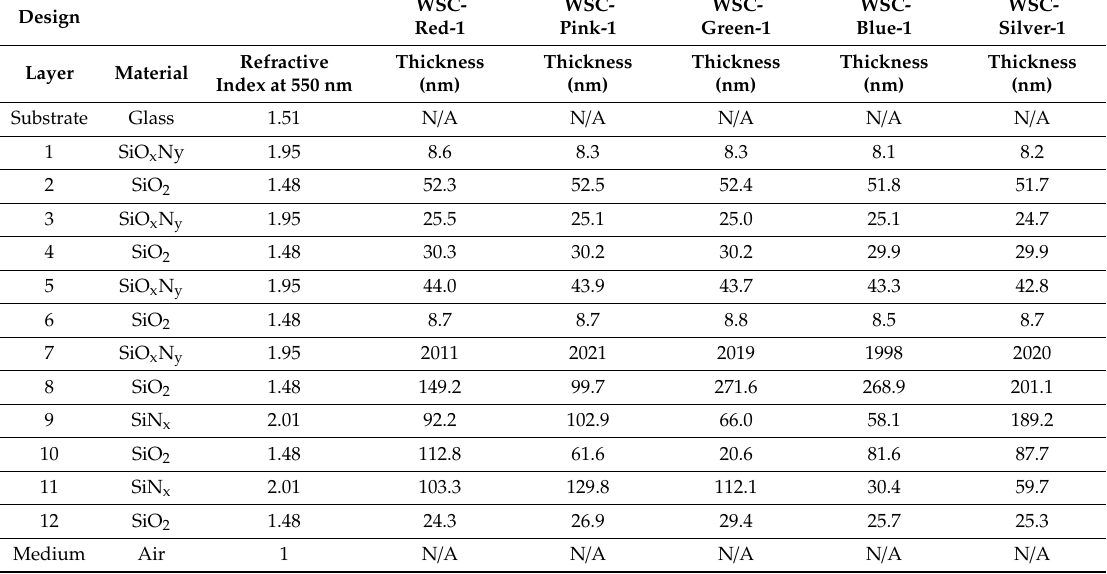
TableA1. SummaryofdetailedcoatingdesignsforsamplesbasedonDesignStrategy1.